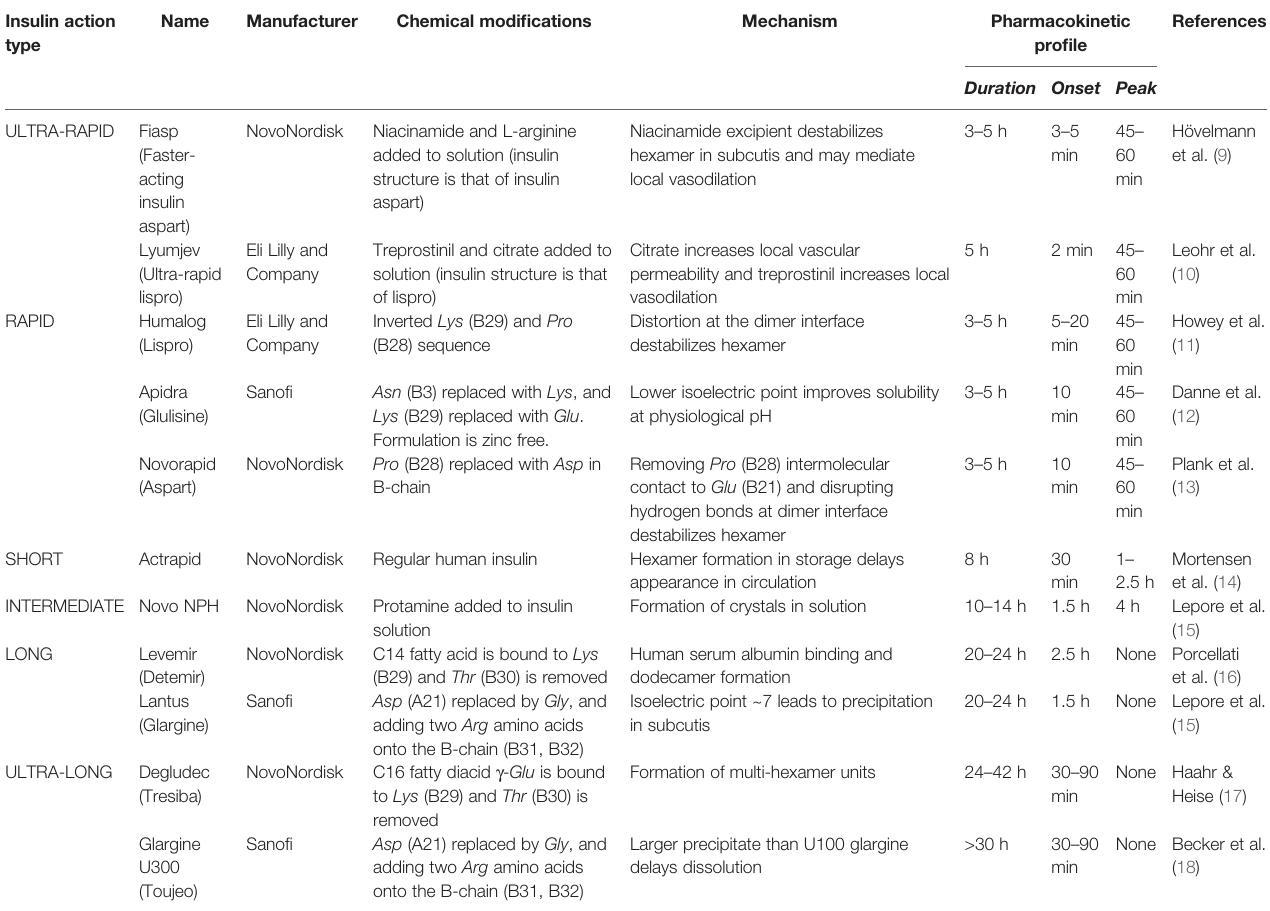
TABLE 1 | Synopsis of the pharmacokinetic properties of exogenous